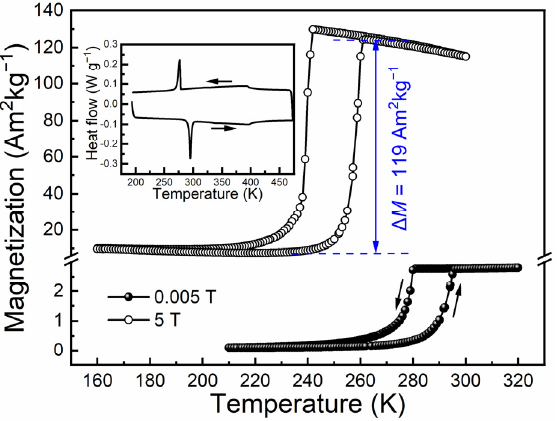
Figure 1. M ( T ) curves for the directionally solidified Ni 44.5 Co 4.9 Mn 37.5 In 13.1 alloy measured under 0.005 T and 5 T. The DSC curves are shown in the inset.